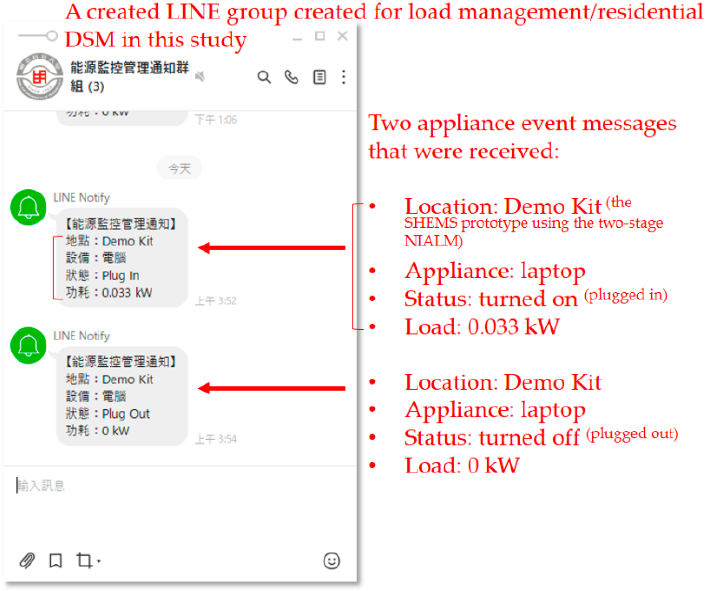
Figure 11. A user interface (UI) developed in Niagara Workbench for the established SHEMS prototype using the presented two-stage NIALM over fog-cloud computing in this study.